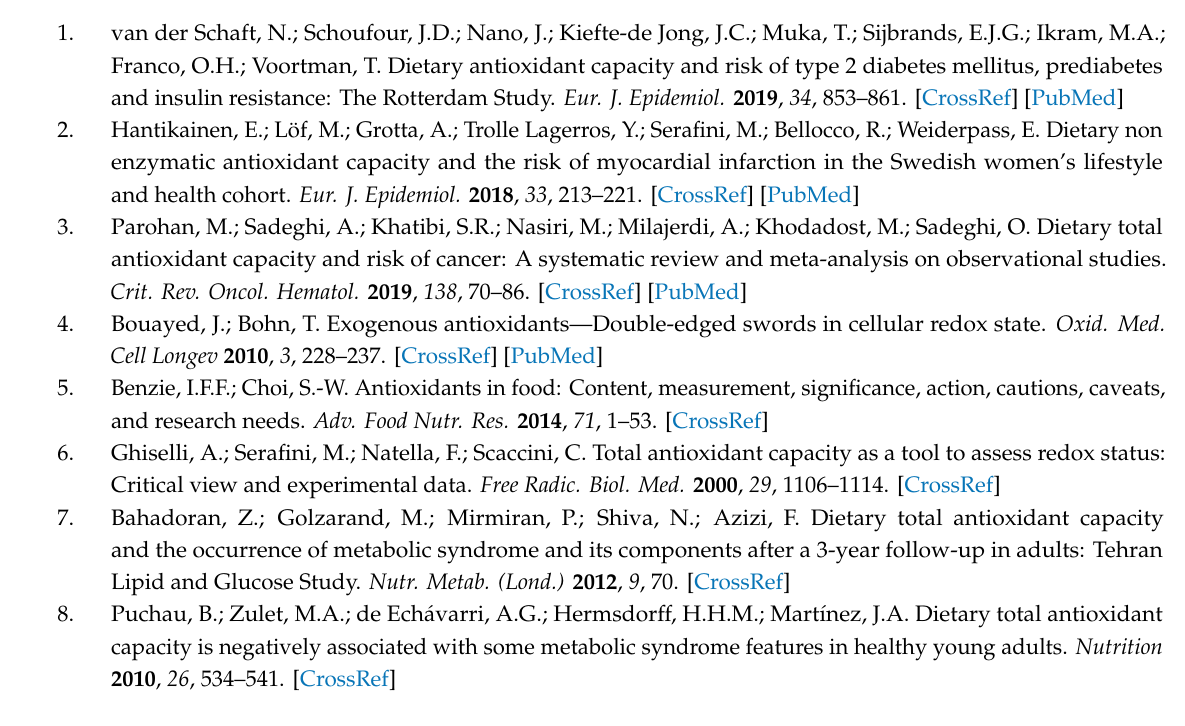
Figure S1: Overview of Rotterdam Study Measurement Rounds, Table S1: Longitudinal associations between Ferric Reducing Ability of Plasma (FRAP) score and fat mass index, fat-free mass index, android-to-gynoid fat ratio, body mass index and body fat percentage; excluding participants with selected comorbidities at baseline. Table S2: Longitudinal associations between Ferric Reducing Ability of Plasma (FRAP) score and hand grip strength; excluding participants with selected comorbidities at baseline. Table S3: Associations between Ferric Reducing Ability of Plasma (FRAP) score and (probable) sarcopenia; excluding participants with selected comorbidities at baseline. Table S4: Longitudinal associations between Ferric Reducing Ability of Plasma (FRAP) score and fat mass index, fat-free mass index, android-to-gynoid fat ratio, body mass index and body fat percentage; stratified by sex. Table S5: Longitudinal associations between Ferric Reducing Ability of Plasma (FRAP) score and hand grip strength; stratified by sex. Table S6: Longitudinal associations between Ferric Reducing Ability of Plasma (FRAP) score and (probable) sarcopenia; stratified by sex. Table S7: Longitudinal associations between Ferric Reducing Ability of Plasma (FRAP) score and fat mass index, fat-free mass index, android-to-gynoid fat ratio, body mass index and body fat percentage; stratified by age. Table S8: Associations between Ferric Reducing Ability of Plasma (FRAP) score and hand grip strength, stratified by age. Table S9: Associations between Ferric Reducing Ability of Plasma (FRAP) score and (probable) sarcopenia, stratified by